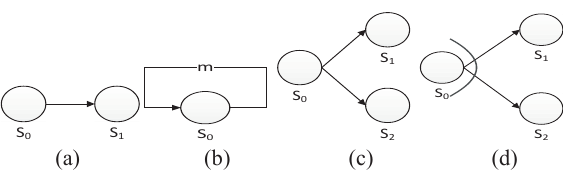
Fig.2. Workflows used in Web service